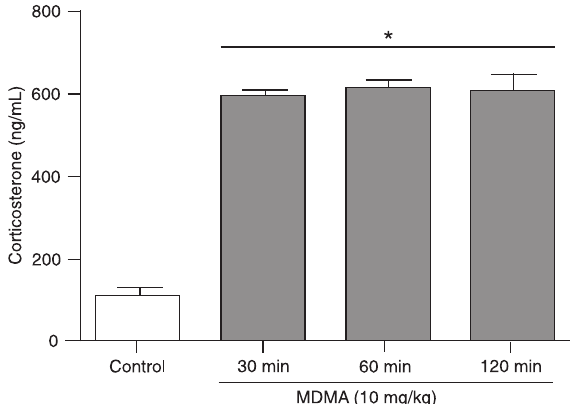
Figure 5. Effects of 3,4-methylenedioxymethamphetamine (MDMA) on corticosterone serum levels 30, 60, and 120 min after administration to BALB/c male mice. Data are reported as means ± SEM for 10 animals/group. *P < 0.05 compared to control (one- way ANOVA followed by Dunnett’s multiple comparison